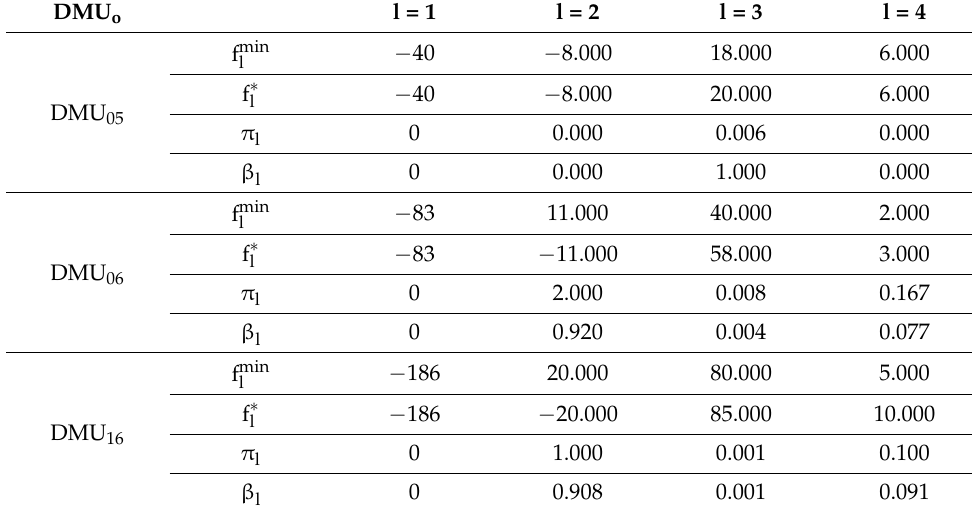
Table 5. Calculating parameters for three DMUs to compose model 14 of step 1 of STEM (p = 1) (related to the second interactive stage) in the first case study.